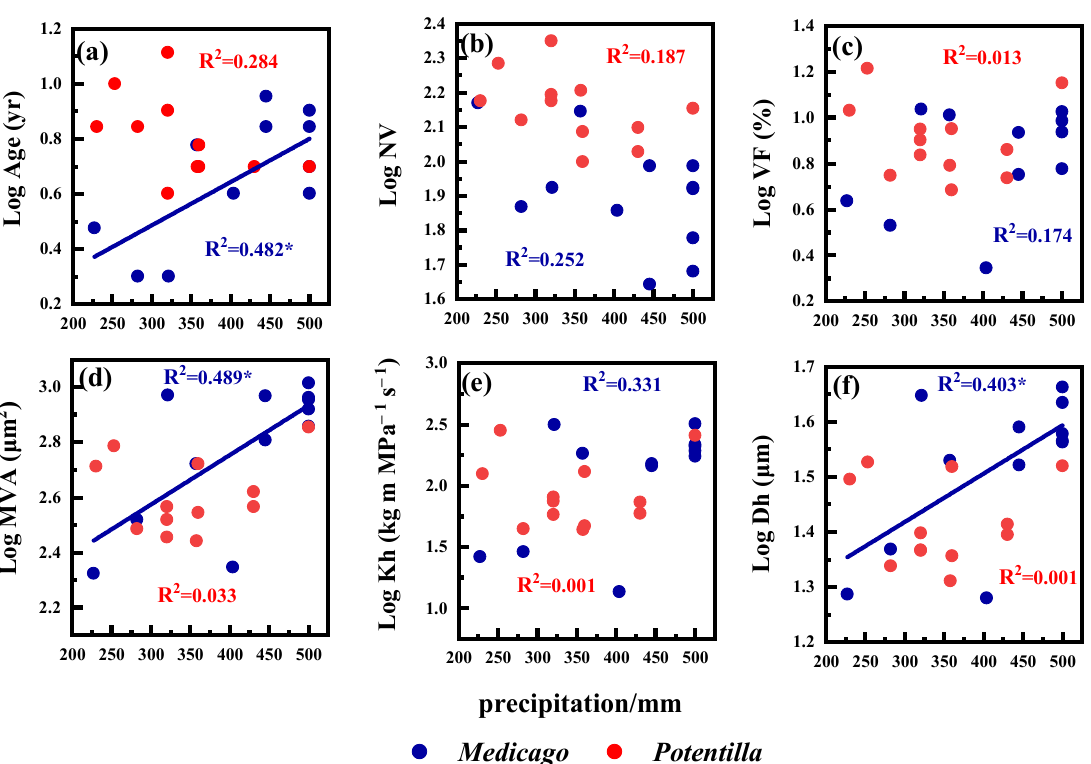
Figure 6. The changing trends of age and the major hydraulic traits in secondary root xylem of non-native and native forbs along a precipitation gradient in arid and semiarid areas. ( a ) age; ( b ) vessel number (NV); ( c ) vessel fraction (VF); ( d ) mean vessel area (MVA); ( e ) the potential hydraulic conductivity (Kh); ( f ) hydraulic diameter (Dh). The blue and red dots indicate Medicago and Potentilla herbaceous species, respectively. * p <